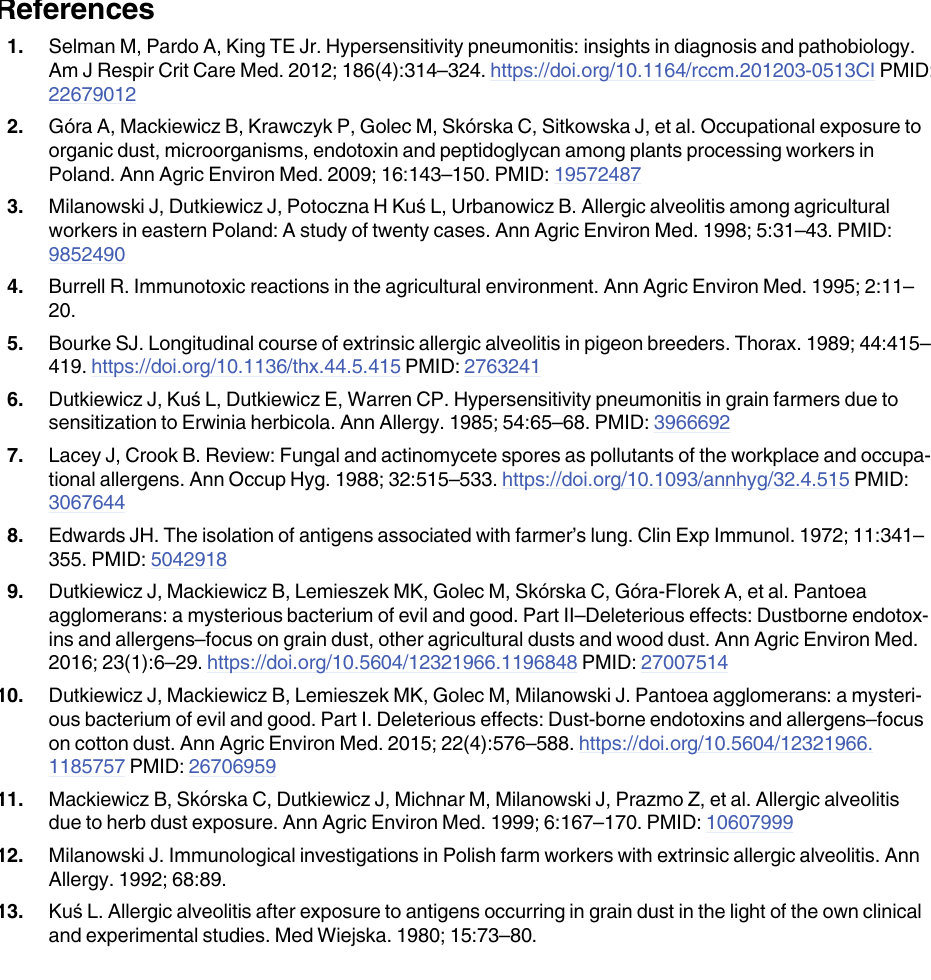
S3 Fig. The representative dot blots for changes presented in Fig 2.